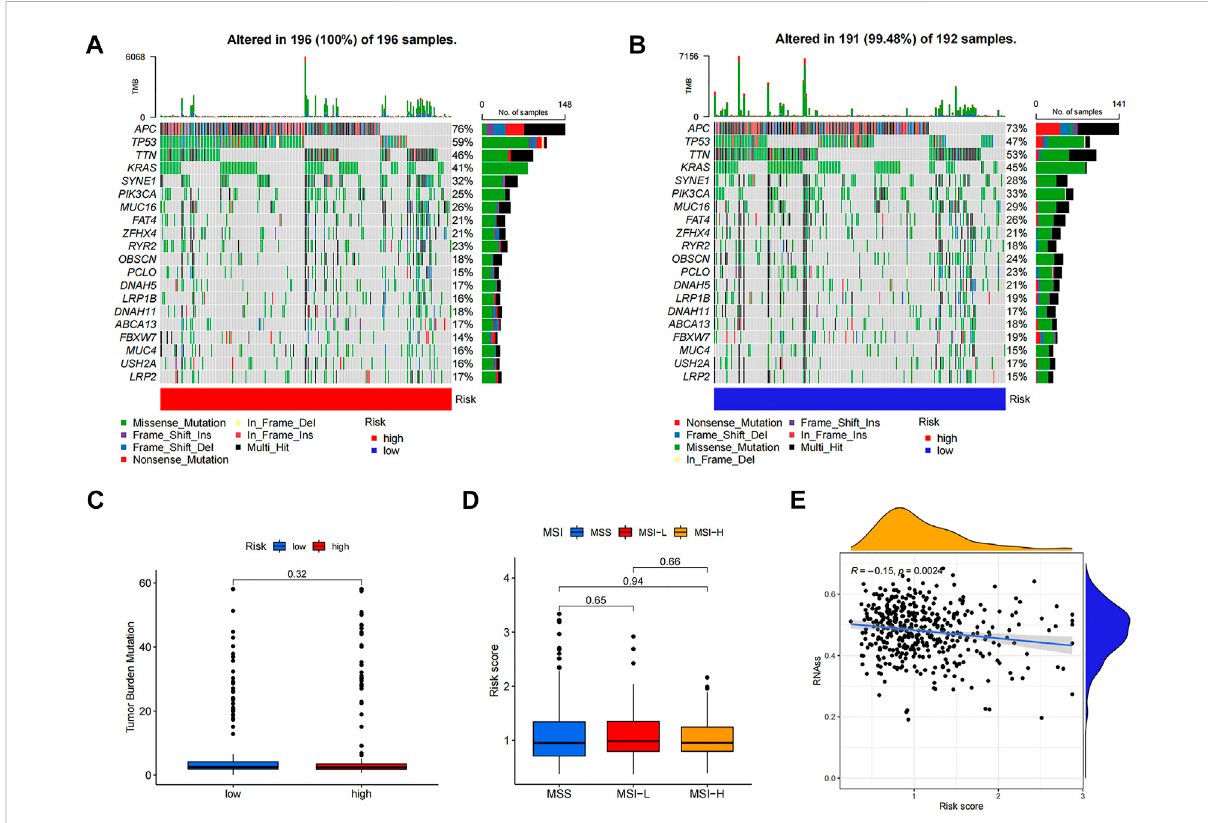
FIGURE 7 Comprehensive analyses of risk score in colon cancer. The somatic gene mutations in high-risk group (A) and low-risk group (B) . TMB (C) and MSI (D) did not show signi fi cant correlations with risk score while CSC (E) negatively correlated with risk score.